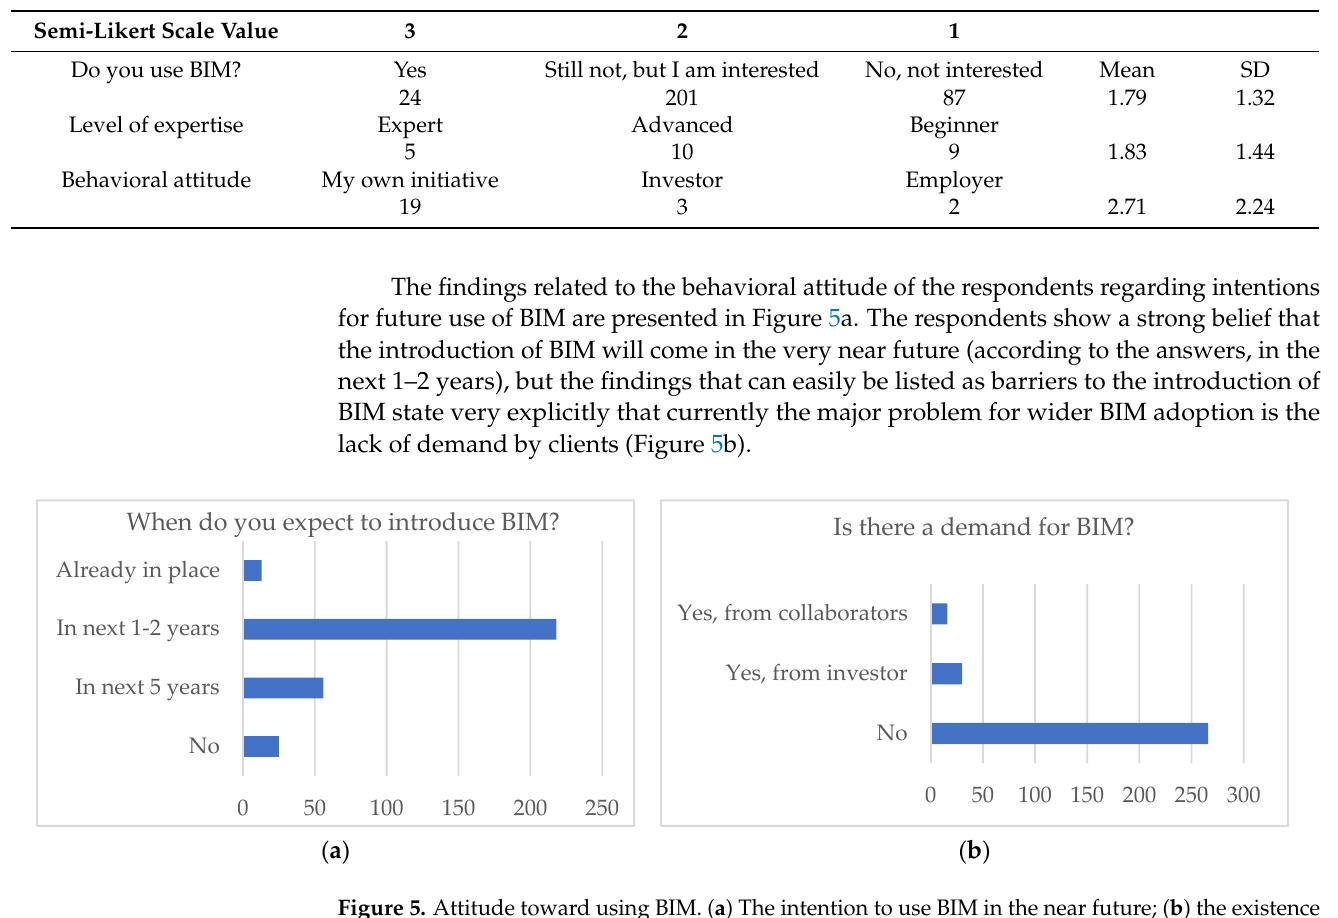
Figure 6. Barriers for BIM adoption identified during the BIM survey in North Macedonia [34].